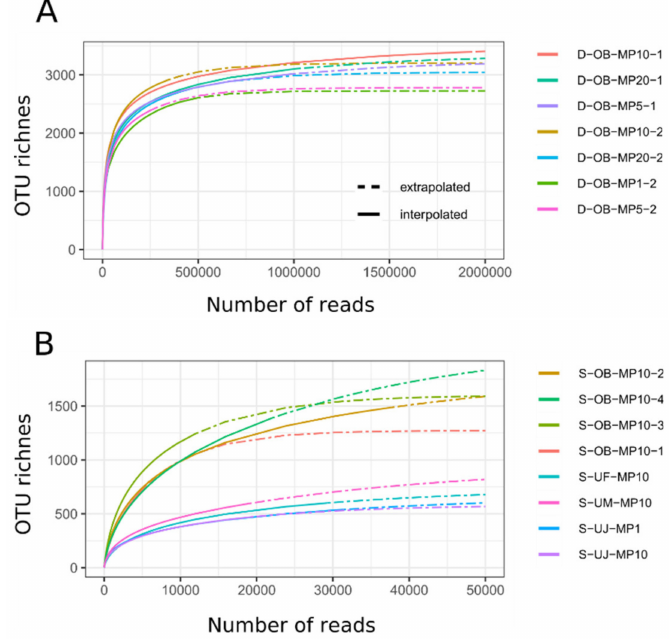
Figure 1. Rarefaction curves for the Mimiviridae polB operational taxonomic units (OTUs) from four samples. ( A ) Datasets produced by the deep sequencing runs. ( B ) Datasets produced by the shallow sequencing run. The rarefaction curves visualize the OTU and read counts detailed in Table